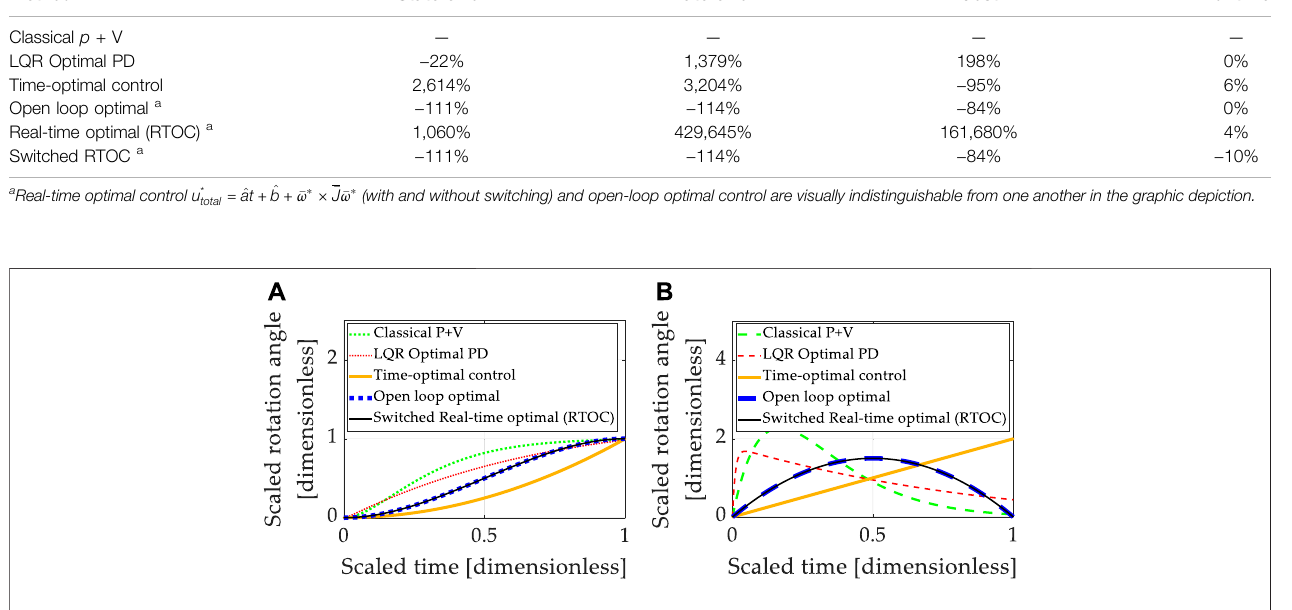
FIGURE 3 | Double-integrator plant (no transport theorem) with control design based on double-integrator. (A) Motion states (translation or rotational) normalized topropagatefromzeroandunityinonenormalizedsecond. (B) Motion rates (translationorrotational)intendedtopropagatefromzeroinitialvelocitytozerovelocityatthe endpoint in one normalized second.